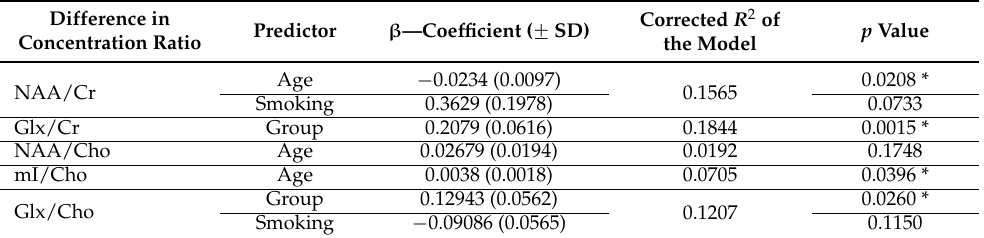
Table 3. Multiple stepwise regression analysis of the determinants of substance concentration ratios in the left frontal WM. The table only contains data for metabolite concentrations that were predicted by the regression